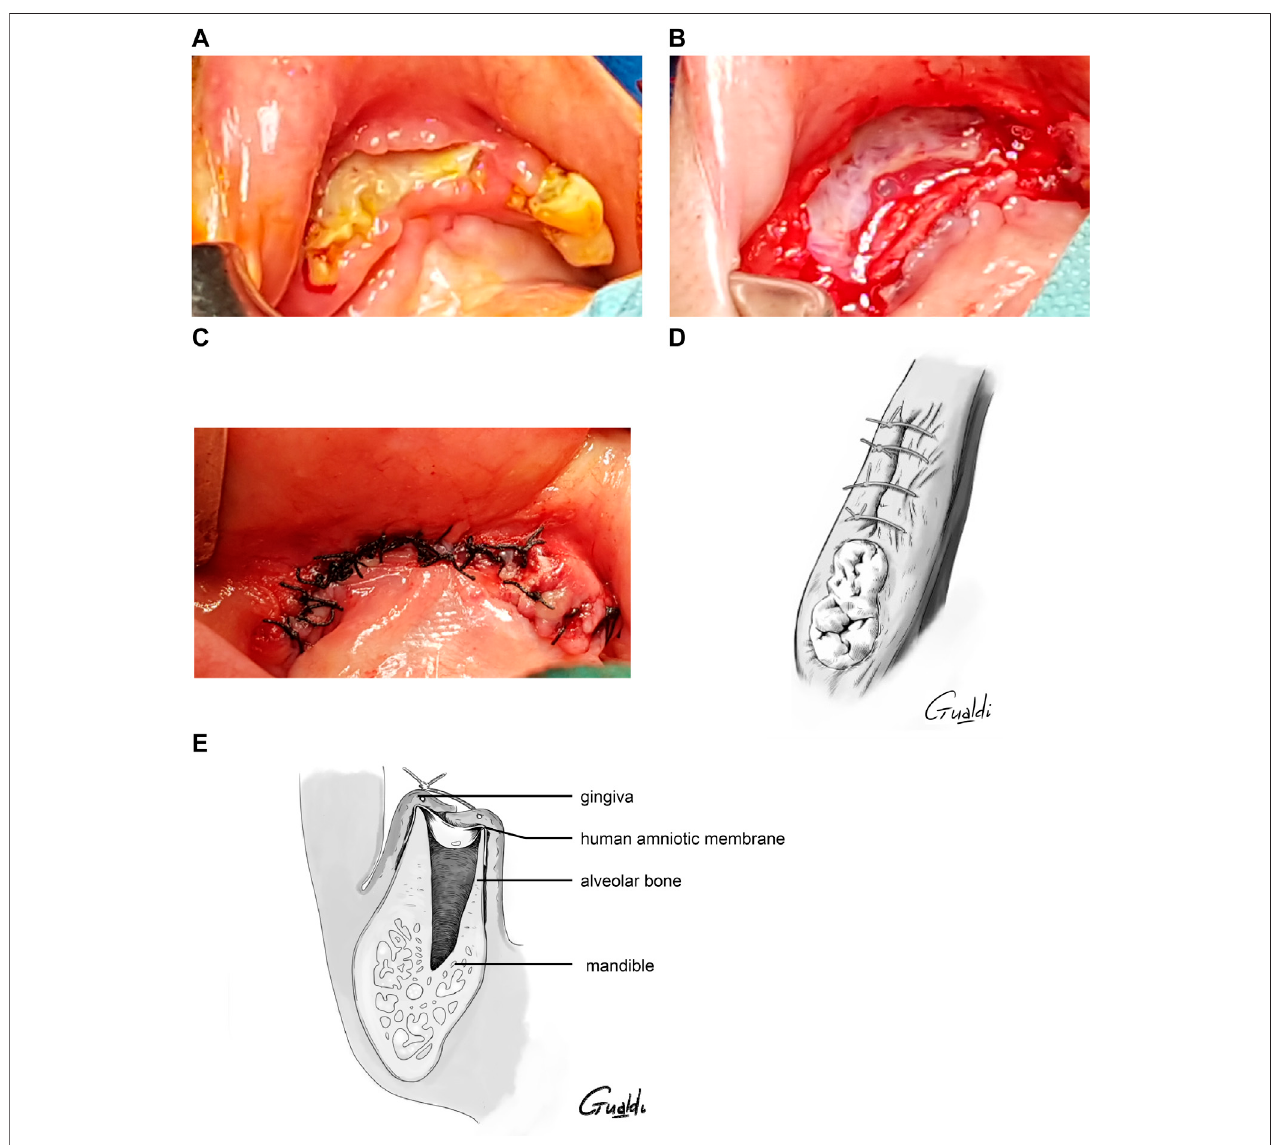
FIGURE 4 | Patient 2 (A) Anterior mandibular stage 2 MRONJ. (B) hAM application. (C) Hermetical sutures from “ hAM implantation with complete coverage ” nomenclature (Odet et al., 2021). Here the sutures were done above the implanted hAM which was not visible. (D) Upper view and (E) Sagittal section illustrations of “ hAM implantation with complete coverage ”